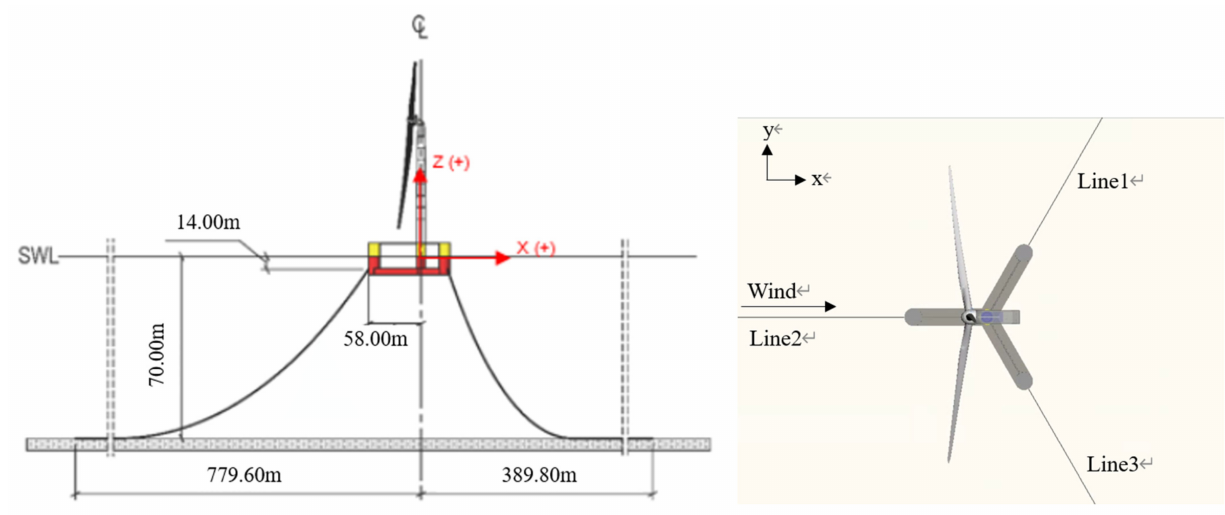
Figure 5. Mooring-System Configuration.